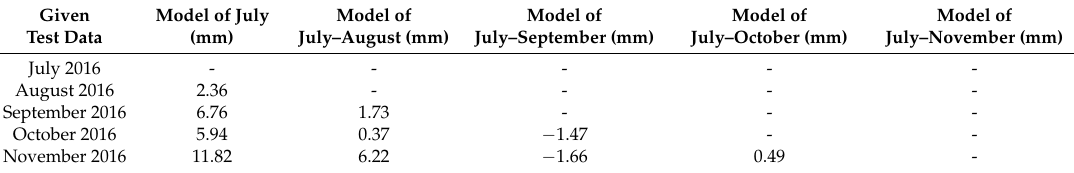
Table 5. Mean-error (ME) values with respect to different sets of test data. Given Test